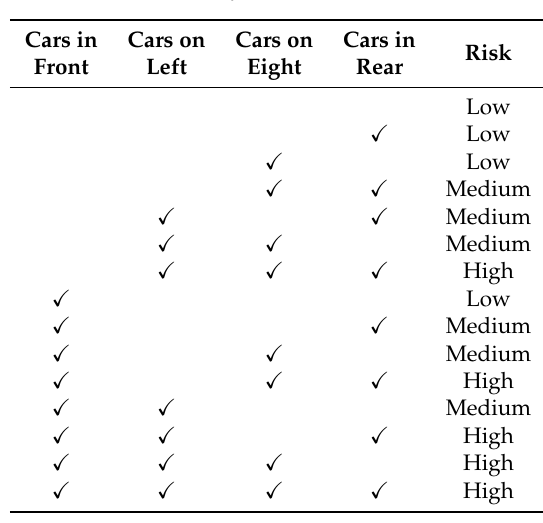
Figure 1. Multilane traffic scenarios. ( a ) Multi-lane one way road scenario; ( b ) Multi-lane two way road scenario. Table 3. Fuzzy rule based for